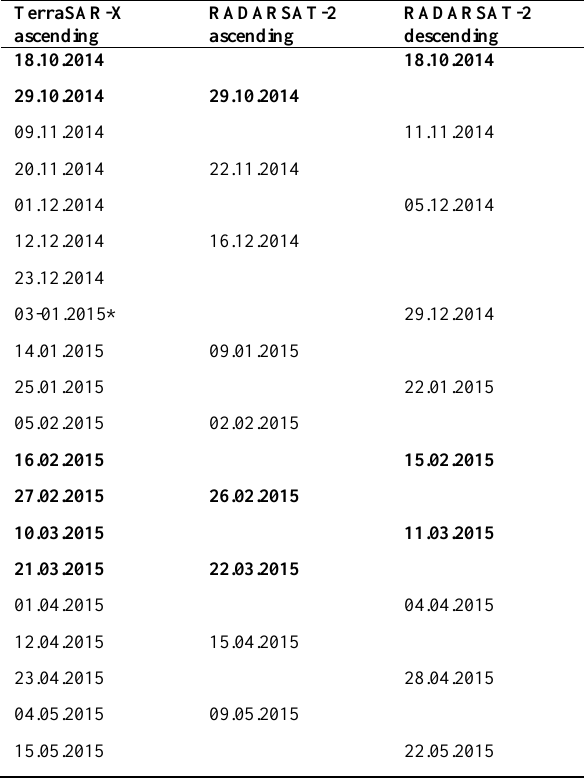
Table 1. Synthetic aperture radar time series